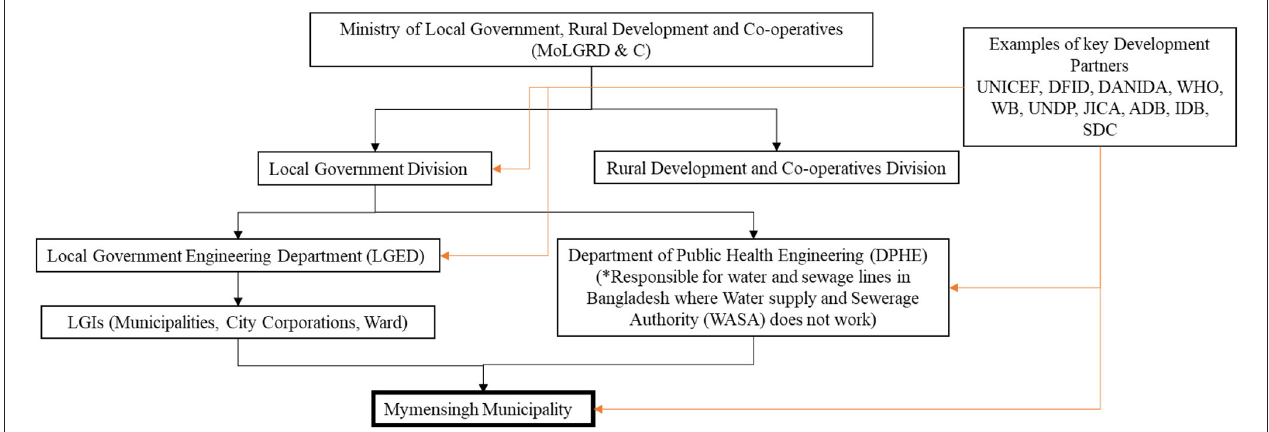
FIGURE 3 | Relevant organizational hierarchy at national and local context. Further details on their respective roles, responsibilities and approaches are presented in Table 2